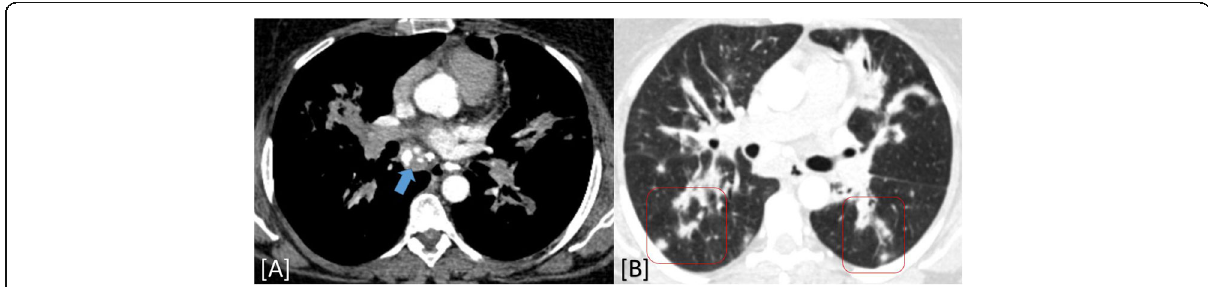
Fig. 10 A 44-year-old patient with active hepatitis and restrictive PFT complaining from progressive dyspnea after 3 months from IFN therapy complaining from progressive dyspnea and restrictive PFT. a , b Axial HRCT chest mediastinal and lung window showing sub-carinal node with calcific foci (blue arrow) together with confluent peri-bronchial fibro-consolidative patches with parenchymal distortion and peri-lymphatic nodules (red-colored squares). Fibrosing sarcoid